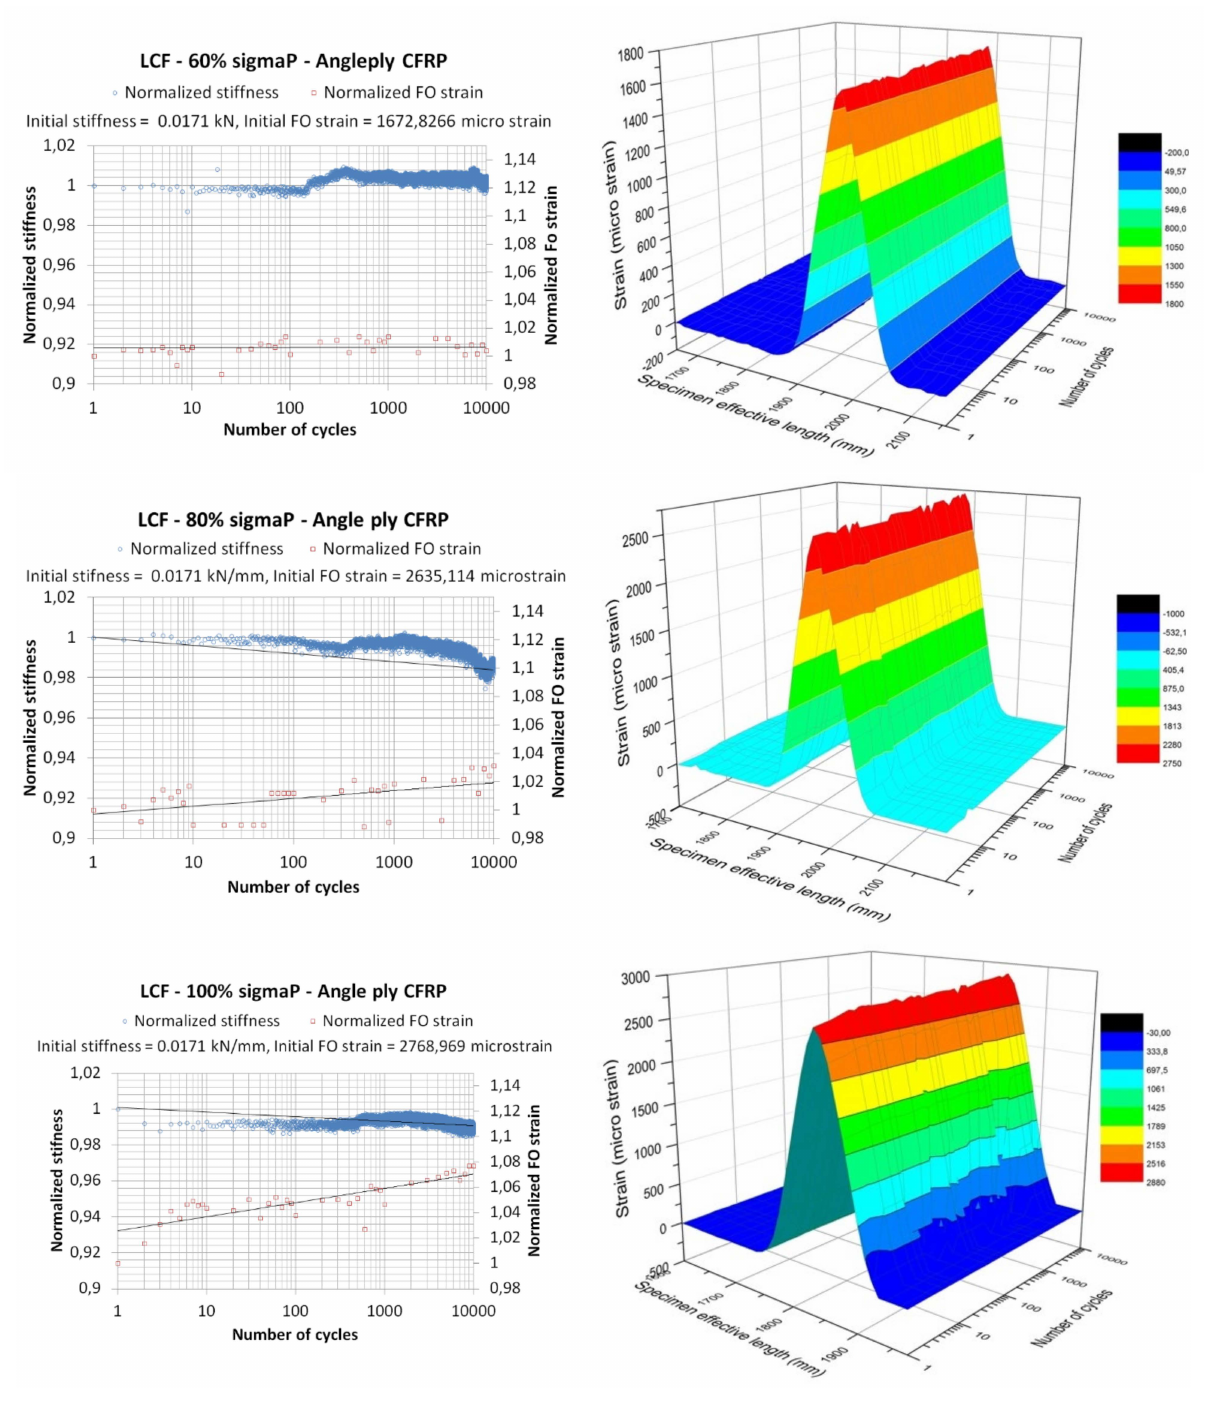
Figure 21. LCF test at a maximum stress of 0.6 σ p, 0.8 σ p, and σ p of angle-ply smart composite along with 3-D corresponding test